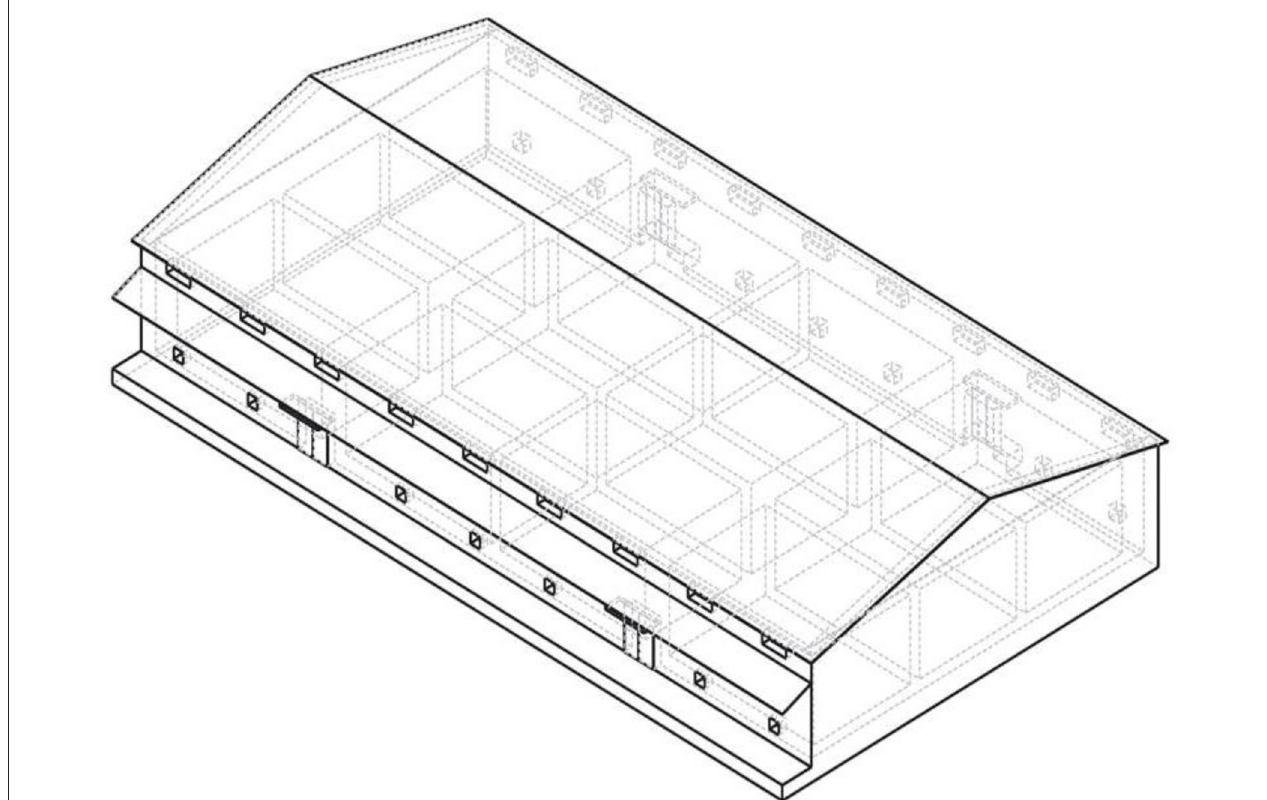
FIGURE 4 | A typical bag storage structure with stacking floor